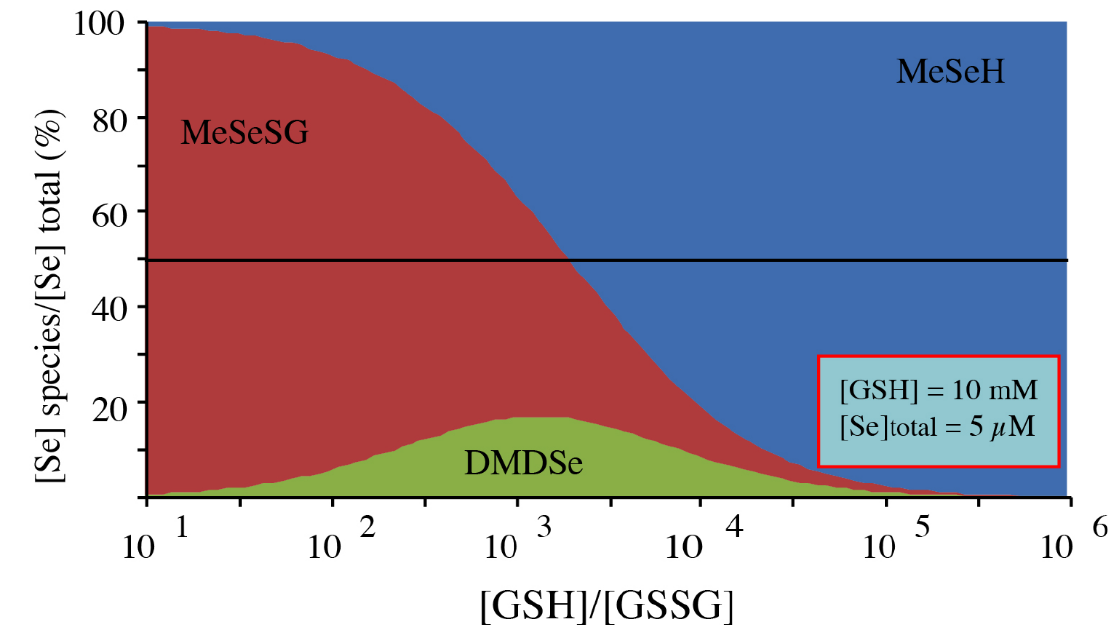
Figure 5. Equilibrium distribution of MeSeH, MeSeSG, and DMDSe as a function of the GSH/GSSG ratio for a GSH concentration of 10 mM and a total Se concentration of 5 µM ([total Se] = [MeSeH] + [MeSeSG] + 2 [DMDSe]). The curves were obtained using values of 1350 for 1/K1 and 1000 for K2.